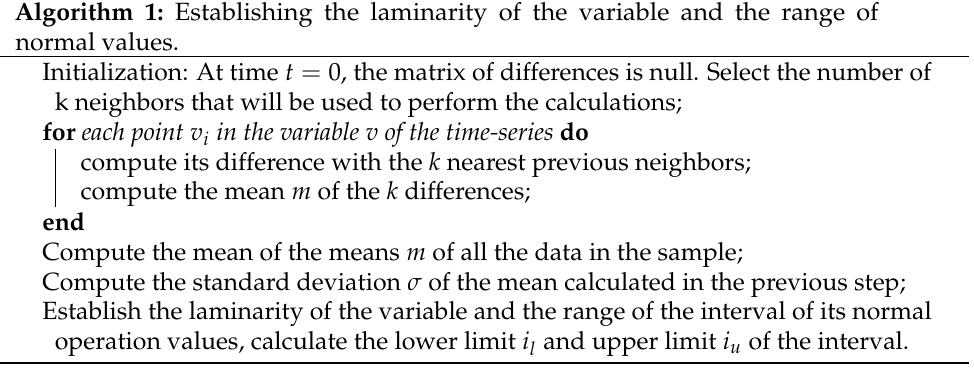
Algorithm 1: Establishing the laminarity of the variable and the range of normal values.